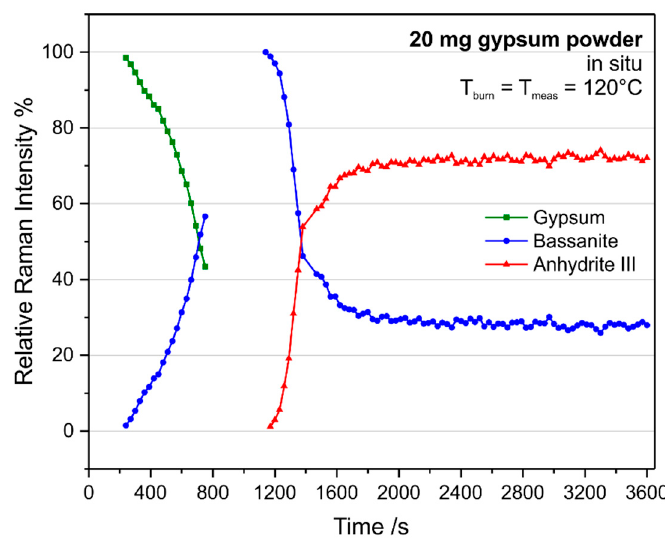
Figure 9. Change of relative intensities of the ν 1 bands of gypsum, bassanite, and anhydrite III during calcination of 20 mg gypsum powder at 120 °C.